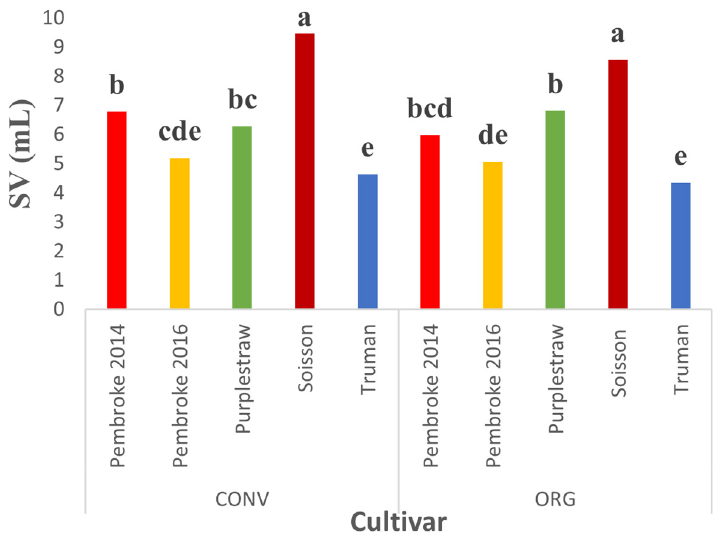
Figure 5. Sedimentation value (SV, mL) as affected by system and cultivar interaction in Y2 ( p = 0.034). Bars with the same letters within each figure are not significantly different based on Tukey’s honest significant difference (HSD) test performed at α = 0.05.